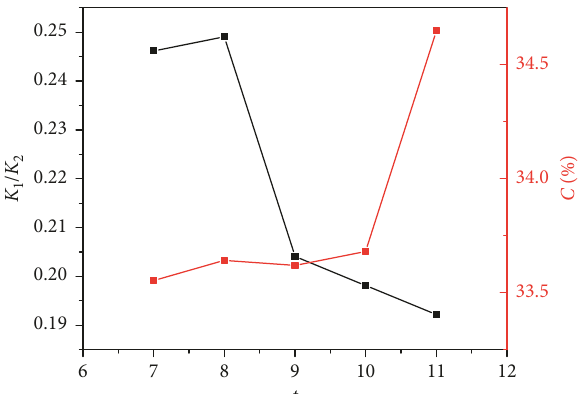
Figure 7: The stiffness-damping characteristics of the GGQ-99 WRI under the lay pitch.